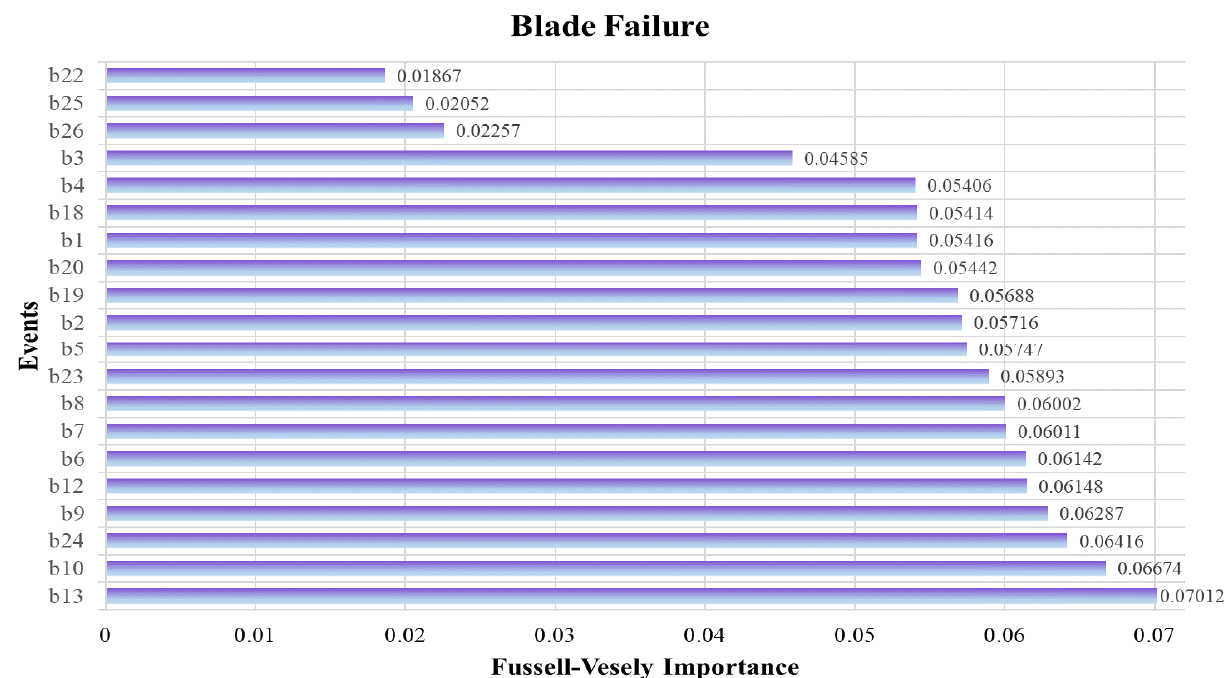
Figure 12. Fussell–Vesely Importance of each basic event of blade failure accident (The event whose Fussell–Vesely importance degree is less than 0.01867 is ignored).